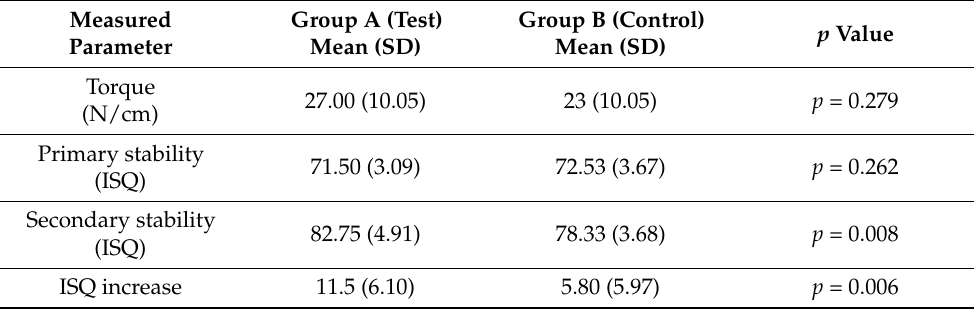
Table 1. Table of descriptive statistics (mean and SD) of the primary stability values measured by insertion torque and RFA, as well as the secondary stability results and the increase in implant stability quotient (ISQ) values during the 6 weeks of the experiment.